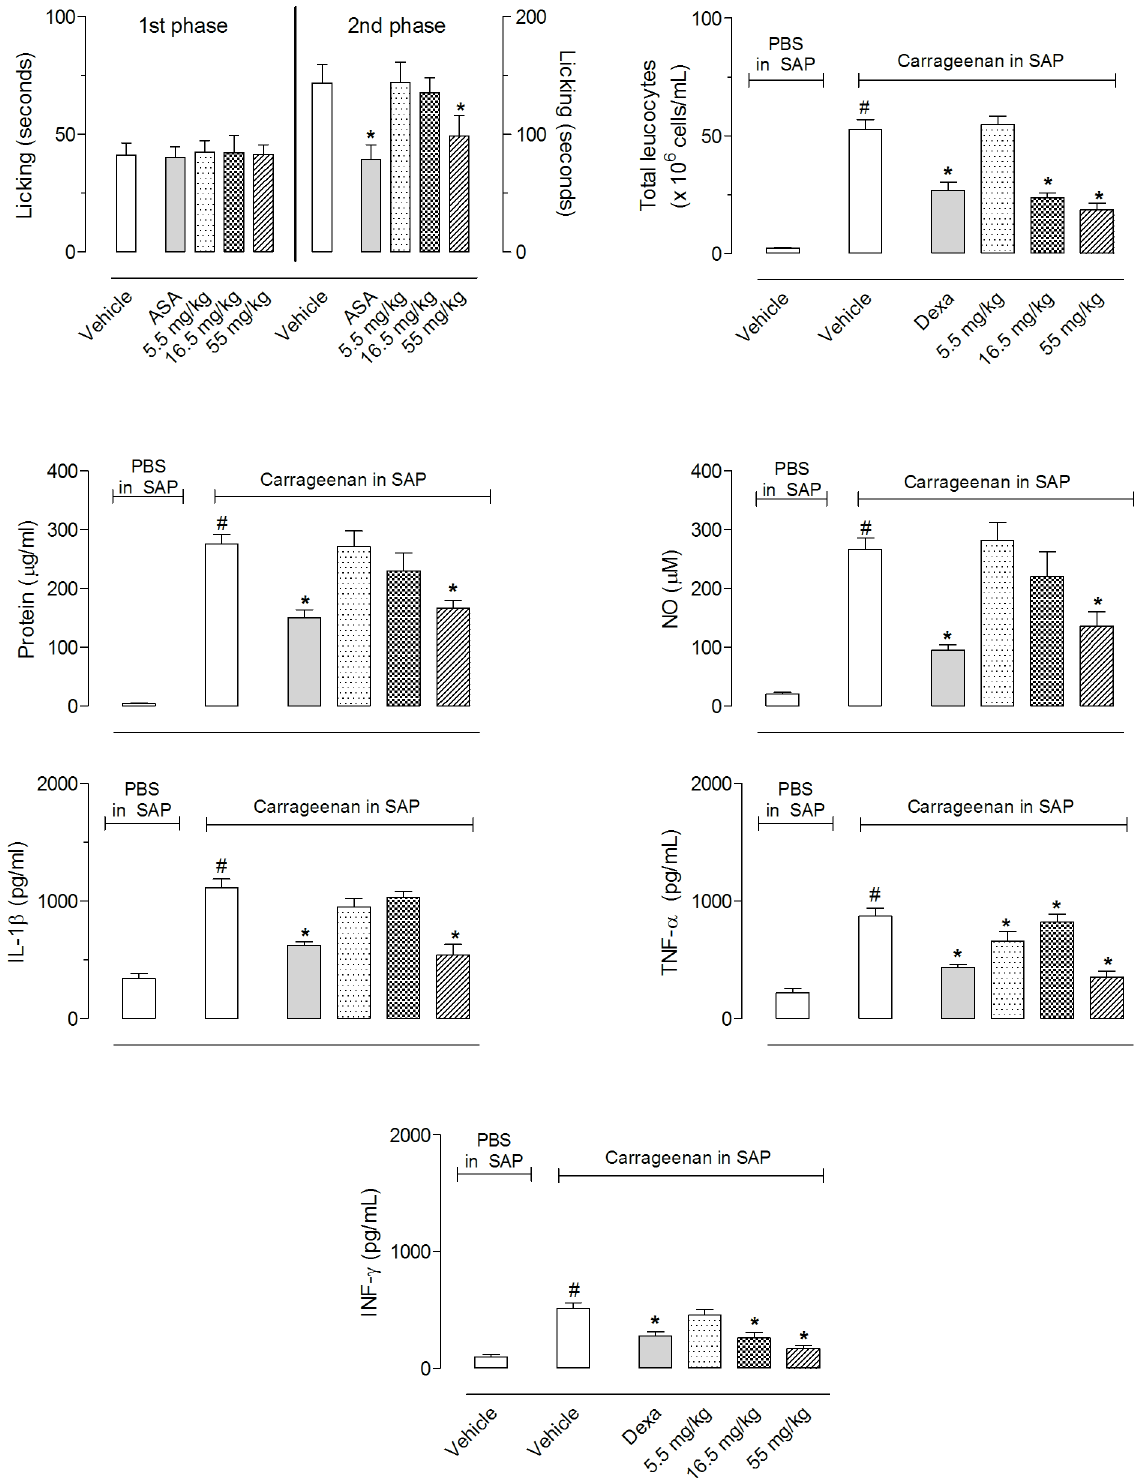
Fig 7. Effect of limonene on formalin-induced licking and SAP models. Animals were pretreated with various doses of limonene (5.5, 16.5 or 55 mg/kg) or vehicle 1 h prior to formalin (1%) or carrageenan (1%) injection. The results are presented as the mean ± S.D. (n = 6 per group). Statistical significance was calculated by ANOVA followed by Bonferroni's test. * P < 0.05 when comparing essential oils-treated animals with carrageenan injected in the SAP with the group that received carrageenan in the SAP.